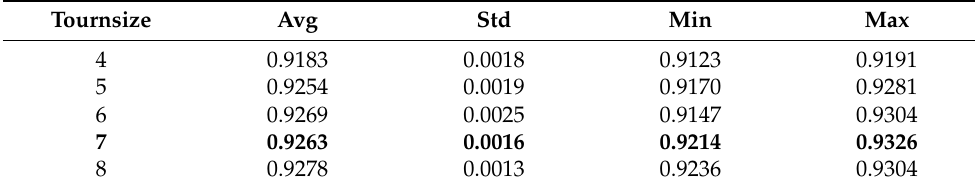
Table 4. Results after varying the tournament size (tournsize).